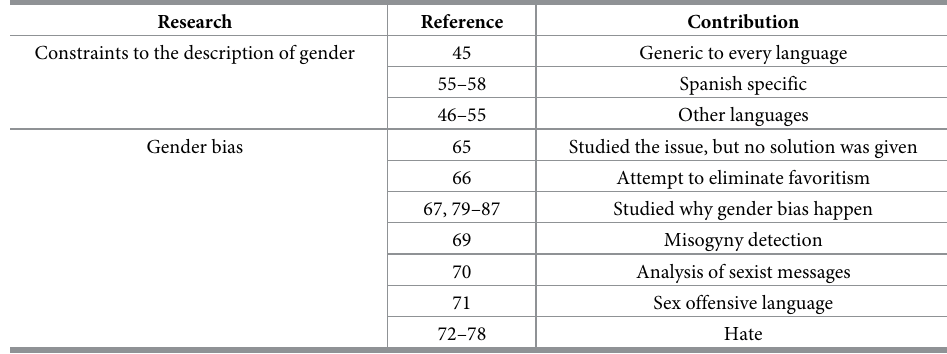
Table 1. Previous works comparative